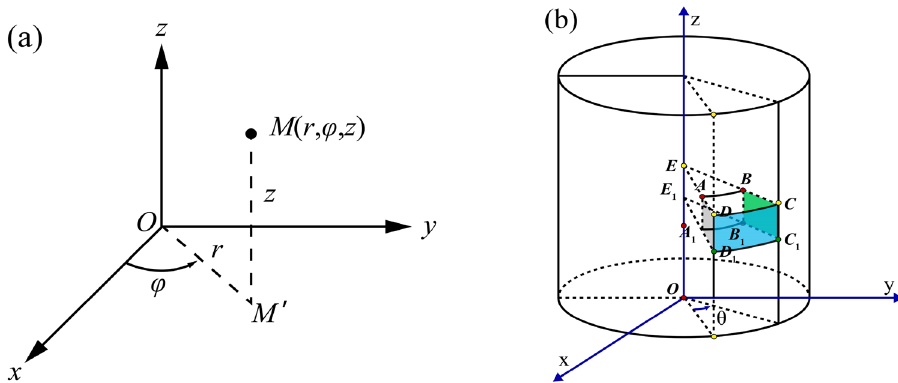
Figure 6. ( a ) Coordinate transformation between cylindrical and cartesian variables; ( b ) Schematic presentation of data point interpolation during gantry rotation along with ion chamber detector arrays.